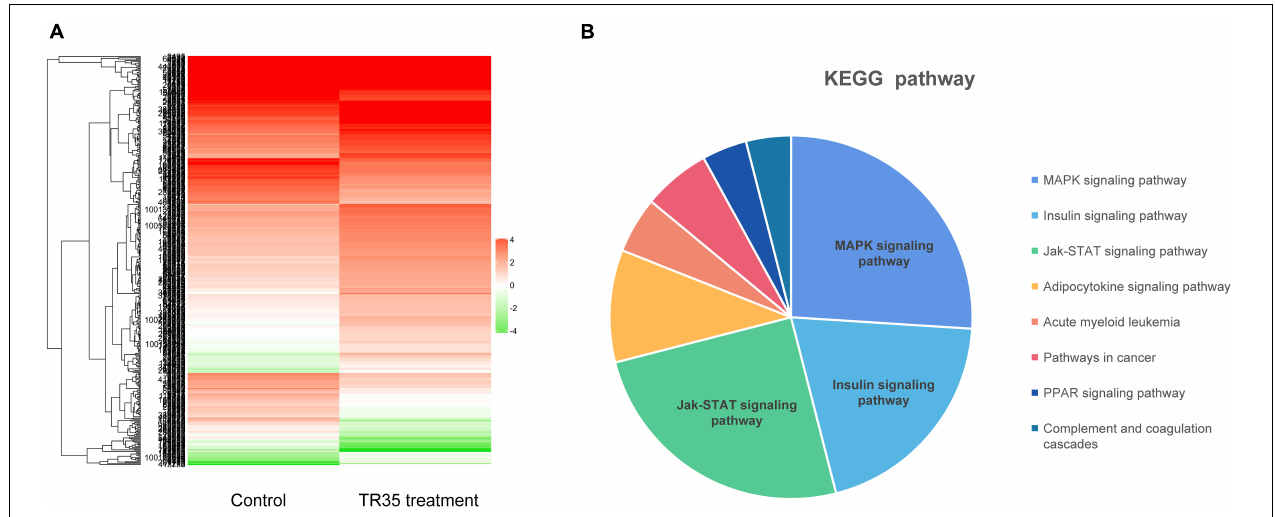
FIGURE 2 | The Heatmap and KEGG pathway enrichment analysis of DEGs in A549 cells after TR35 treatment. (A) Heatmap of expression profile for the 433 DEGs. (B) KEGG pathway enrichment analysis of DEGs.